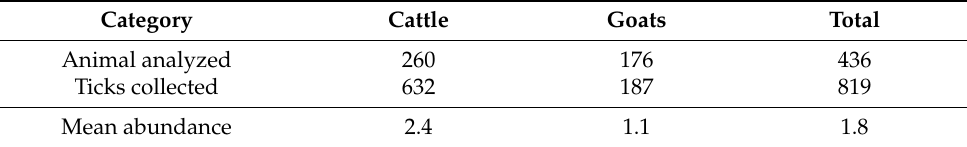
Table 4. Mean ticks abundance in cattle and goats d .